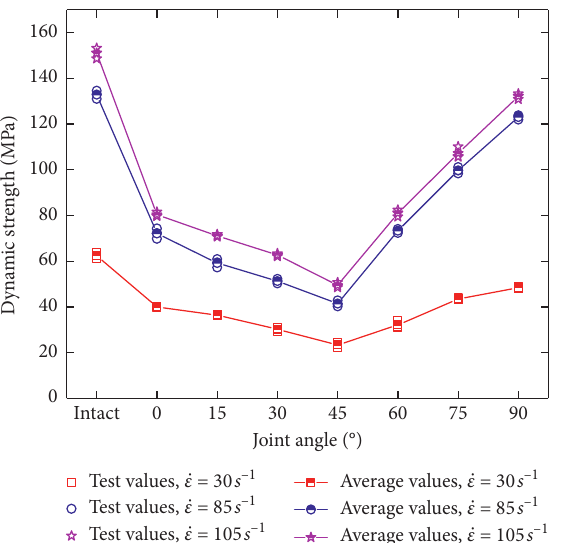
Figure 5: Relationship between dynamic compressive strength and joint angle under three different strain rates.